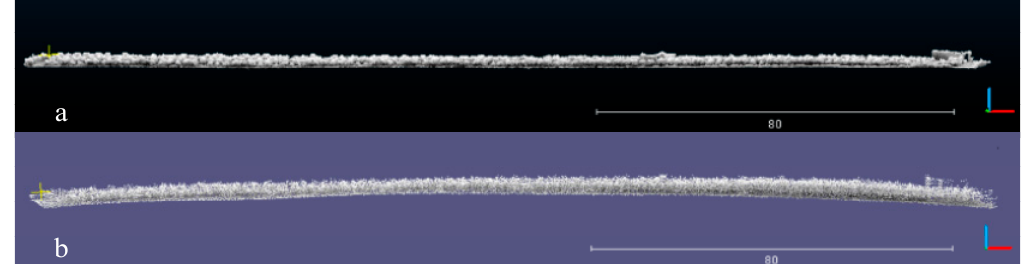
Figure 7. Side view of the orchard reconstruction environment based on point clouds: ( a ) improved and ( b ) unimproved mapping algorithms.